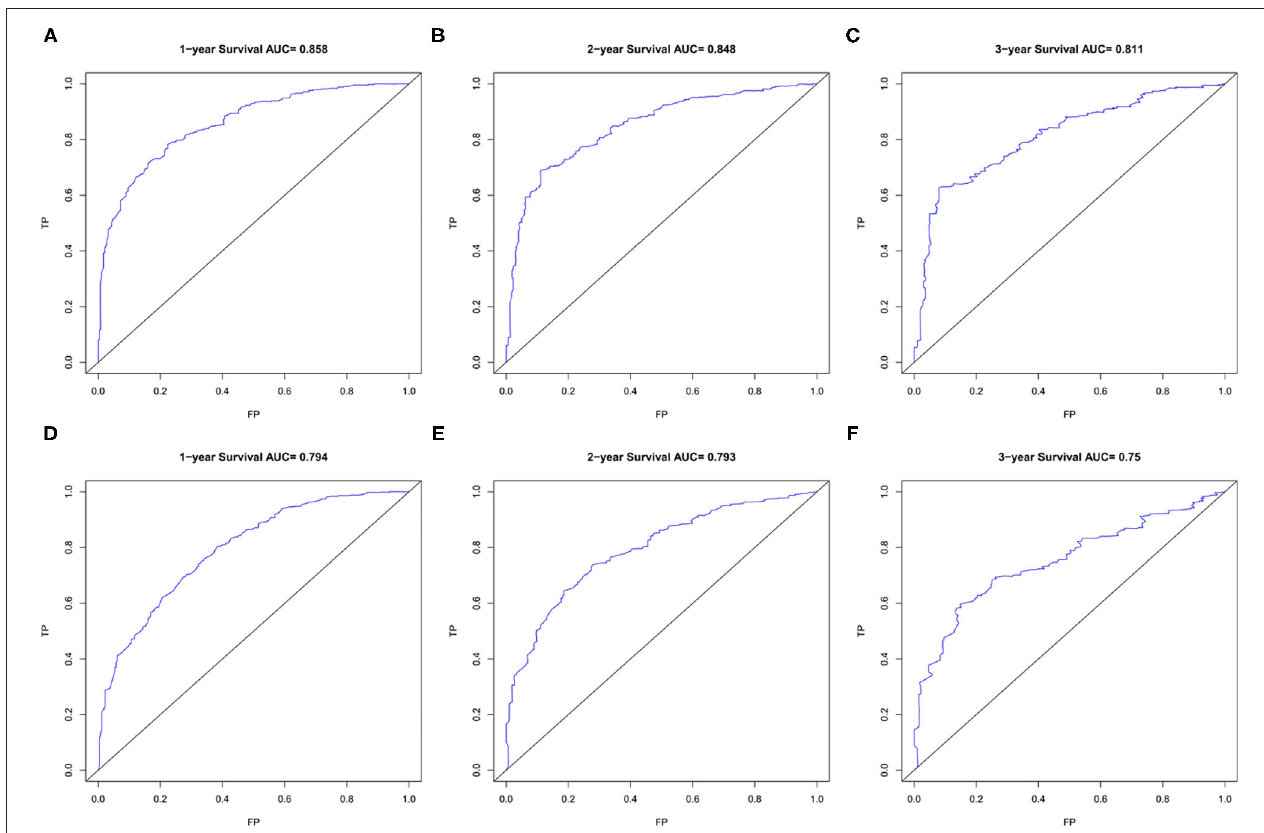
FIGURE 6 | The ROC curves of the nomogram for 1-, 2-, and 3-year OS prediction (A–C) and CSS prediction (D–F) . OS, overall survival; CSS, cancer-specific survival.